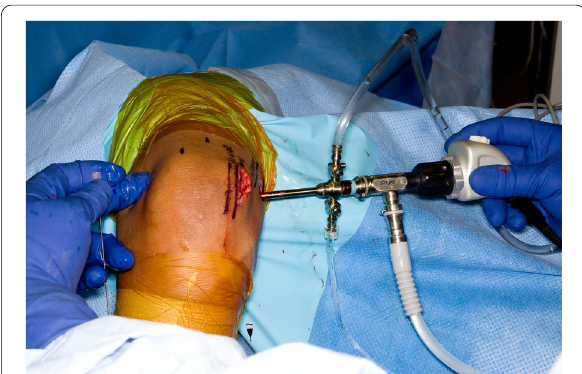
Fig. 3 Arthroscopic osteocapsular arthroplasty performed in the lateral decubitus position. In situ decompression of the ulnar